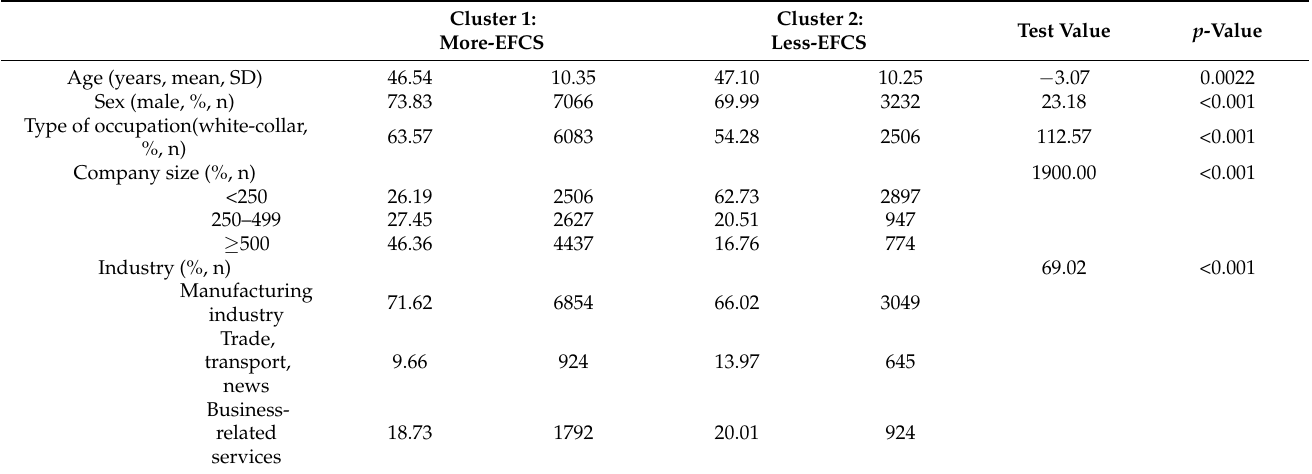
Table 1. Description of the study population according to the